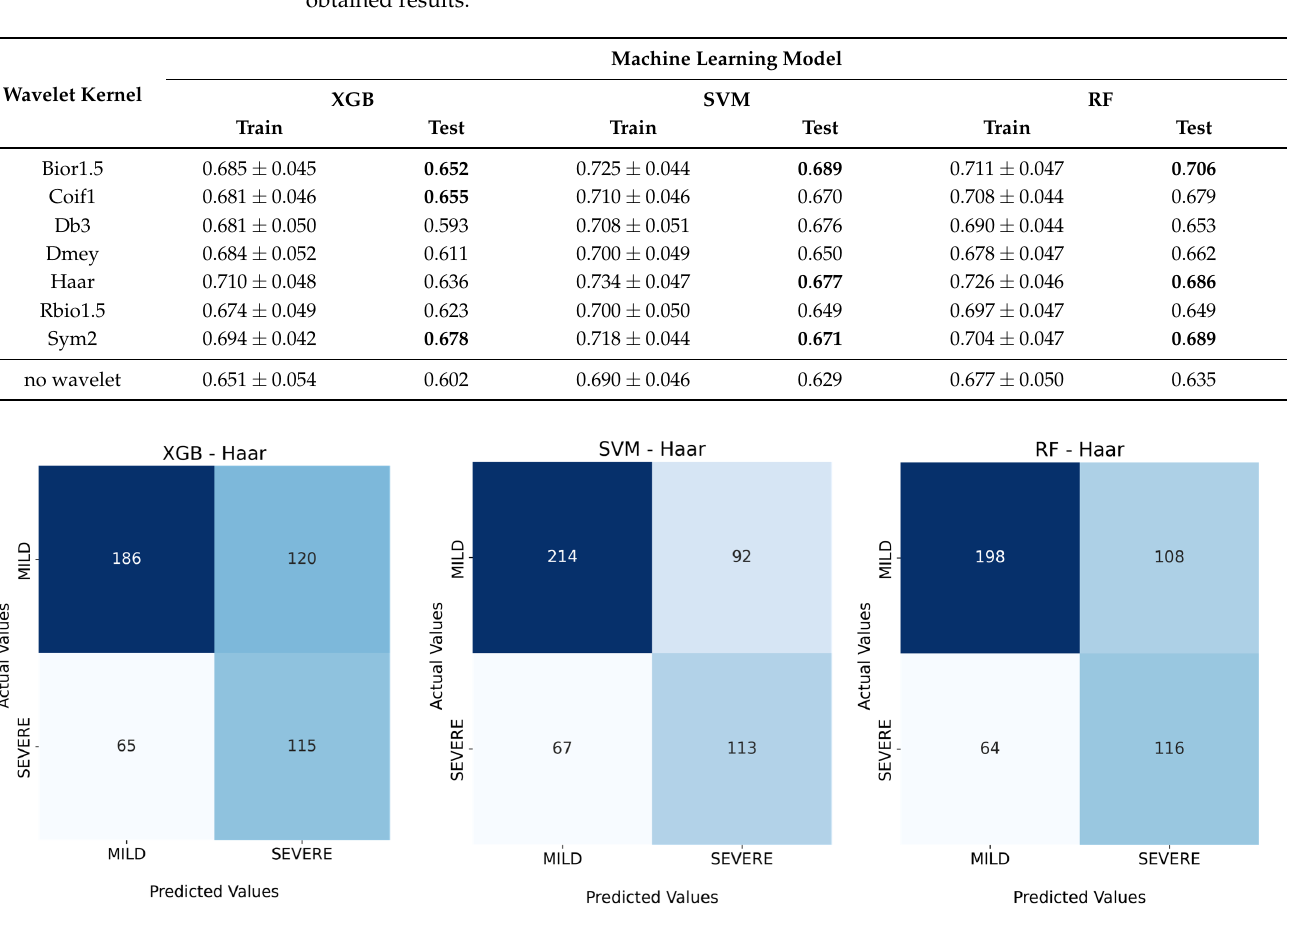
Table 7. AUROC values obtained in training ( mean ± standard deviation ) and in testing phases for each wavelet kernel with three ML models considered. Boldface values highlight the best three obtained results.